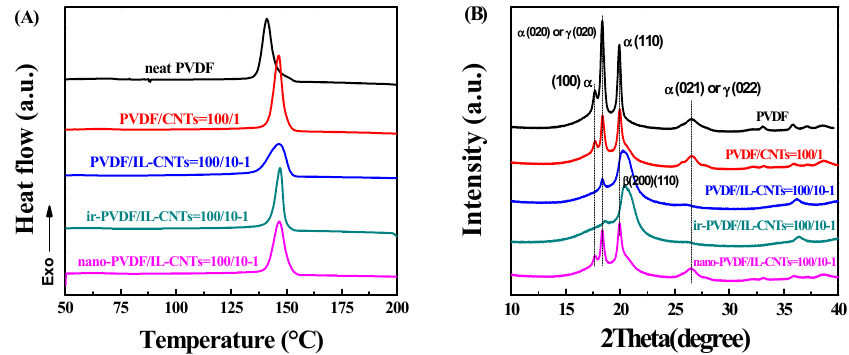
Figure 5. Characterization of crystallization behaviors of nano-PVDF/IL-CNTs (100/10-1) nanocomposite in comparison with its counterparts, including neat PVDF, PVDF/CNTs (100/1), PVDF/IL-CNTs (100/10-1) and ir-PVDF/IL-CNTs (100/10-1). ( A ): Differential scanning calorimeter (DSC) cooling curves with a 10 °C /min cooling rate; ( B ) Wide-angle X-ray diffraction (WAXD) patterns in the range of 10 ° –40 ° with a scanning rate of 1 ° /min.